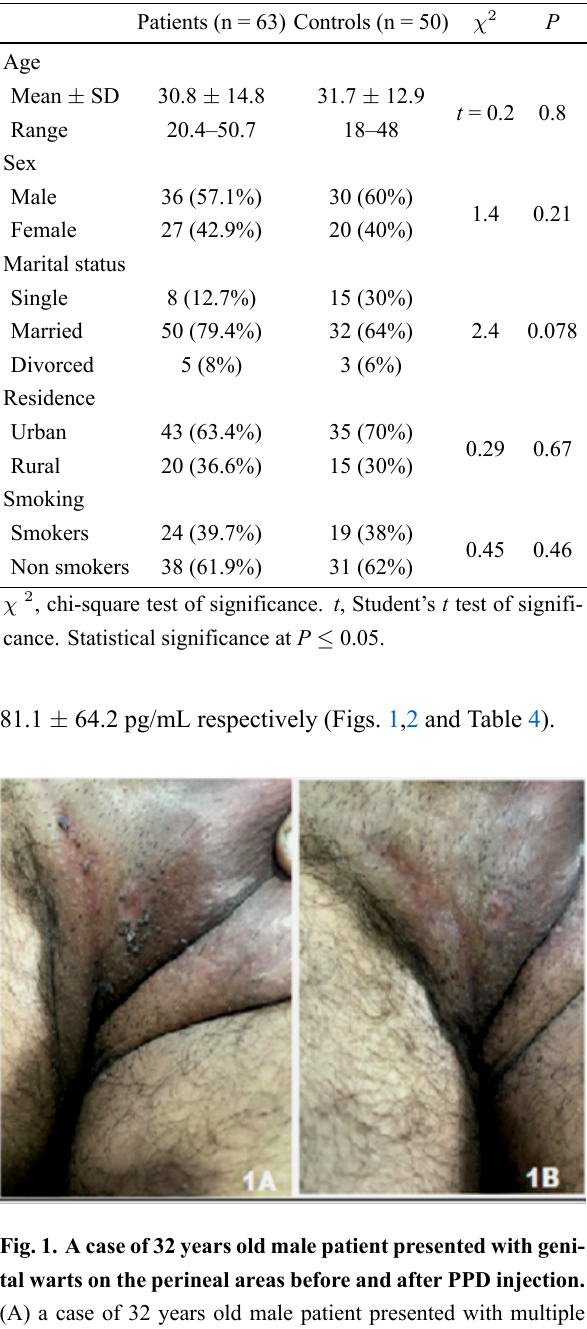
Table 1. Sociodemographic data of the studied patients and control group.